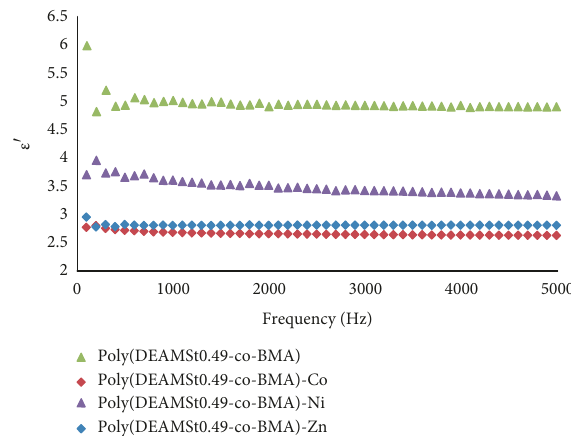
Figure 11: Dielectric constant change of the poly(DEAMSt0.49-co- BMA) ligand and the poly(DEAMSt0.49-co-BMA)-M metal complexes versus frequency (M: Co(II), Ni(II), an dZn(II)).